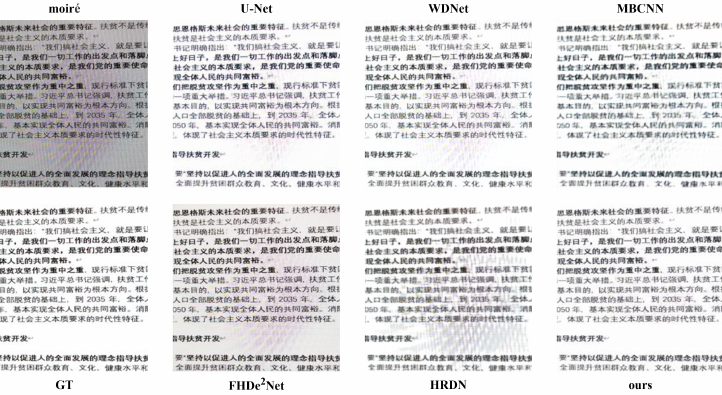
Figure 5. Visual comparisons between our proposed FSD-Net and other methods. The example image contains serious moiré patterns.